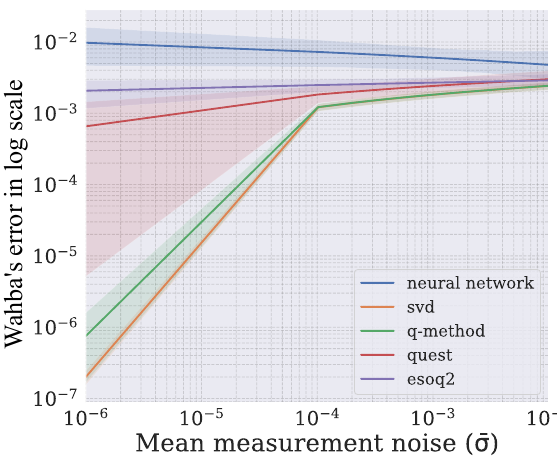
Figure 13. Impact of the average measurement noise on model